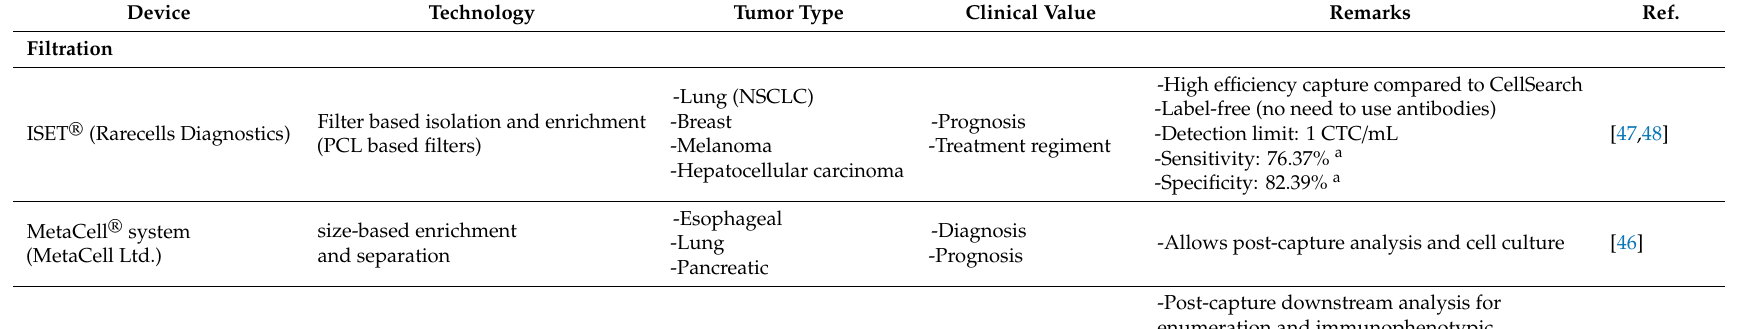
Table 3. Commercially available platforms for CTC detections based on their biophysical properties (label-free